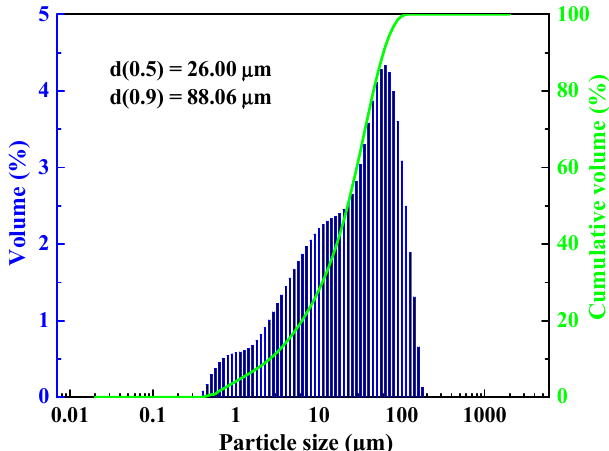
Figure 1. Particle size distribution of soil for backfilling.